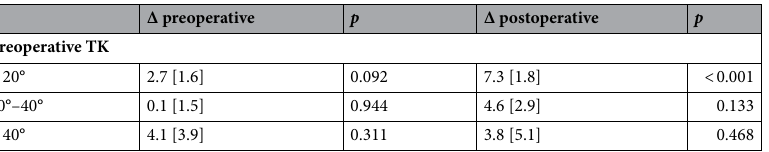
Table 7. Difference between pre and postoperative TK values within group 1 and group 2; mean [standard deviation]; analysis performed using IBM SPSS Statistics 21. TK, thoracic kyphosis.